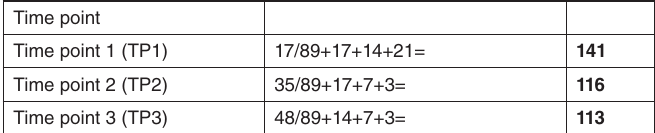
Table 3: Total number of inventory completions at each time point